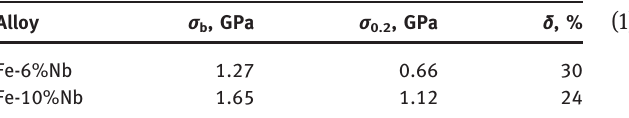
Table 2: The compressive properties of the Fe-6%Nb and Fe-10%Nb